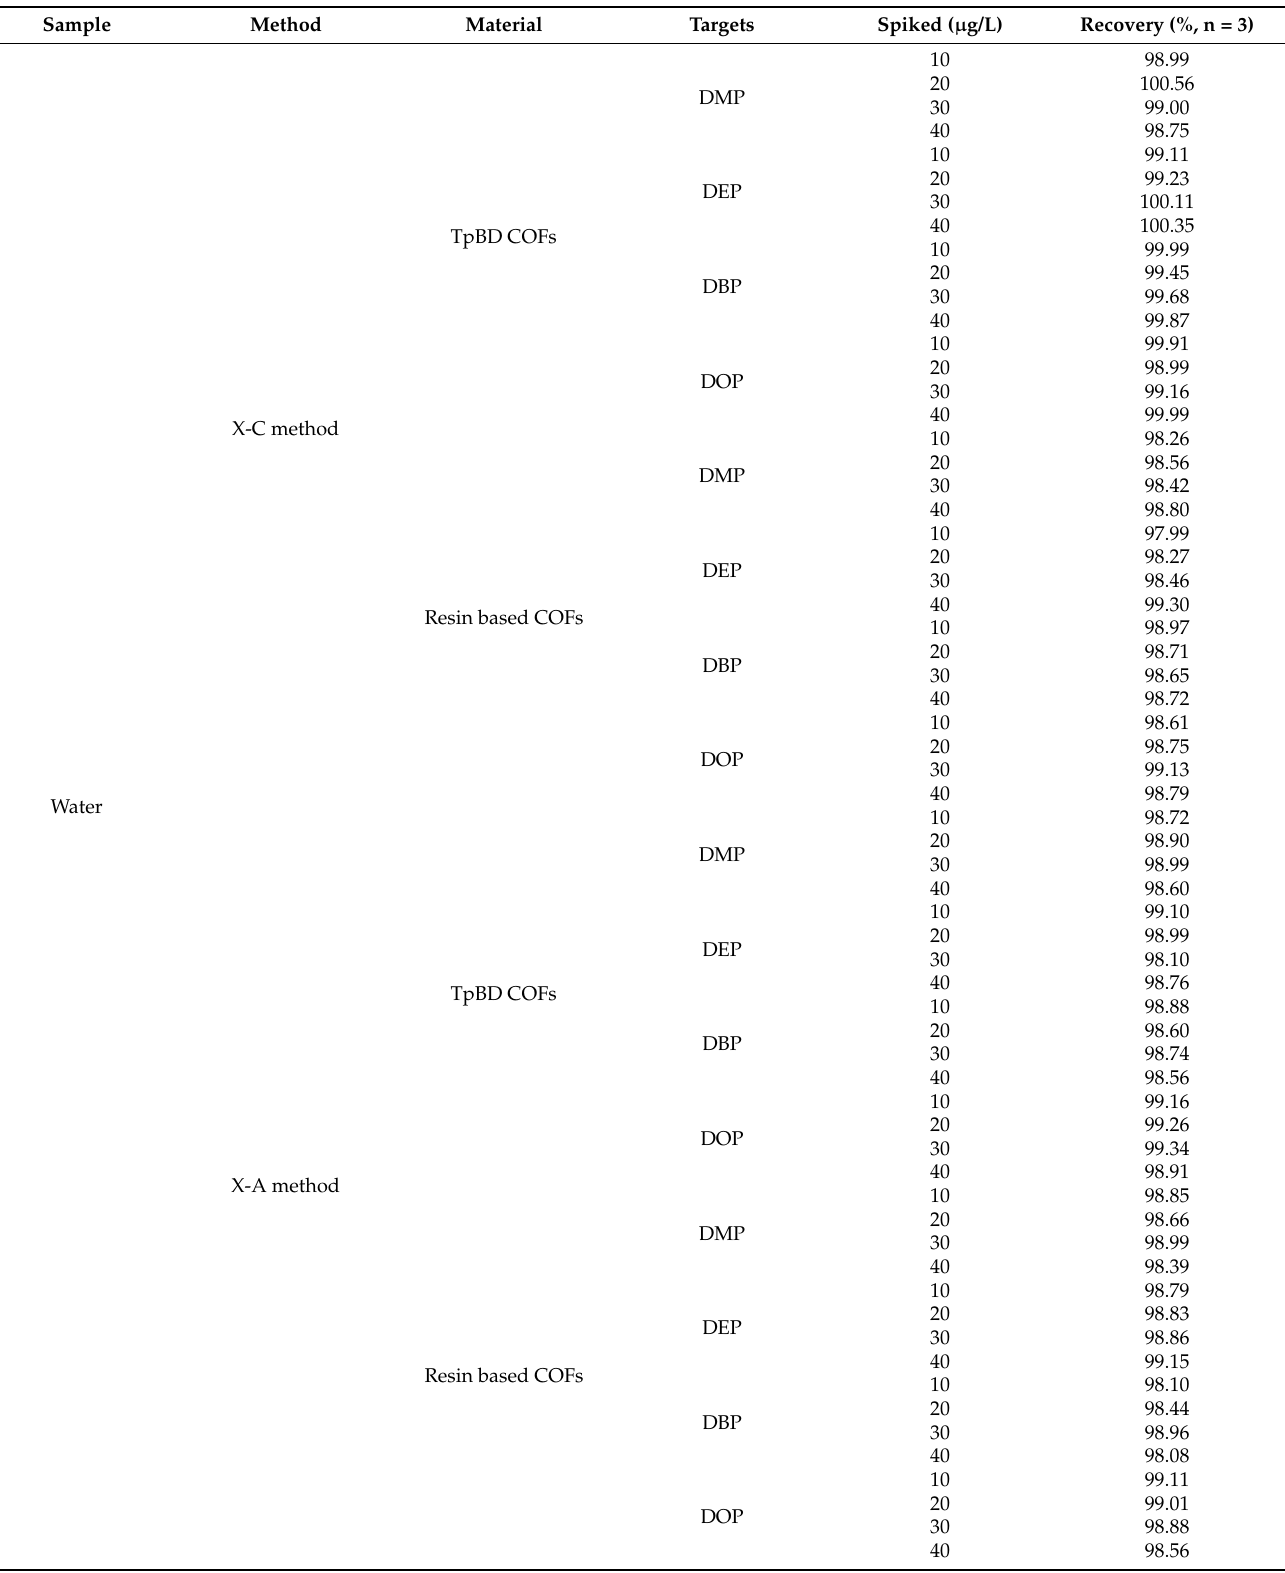
Table 9. Analysis of labeled